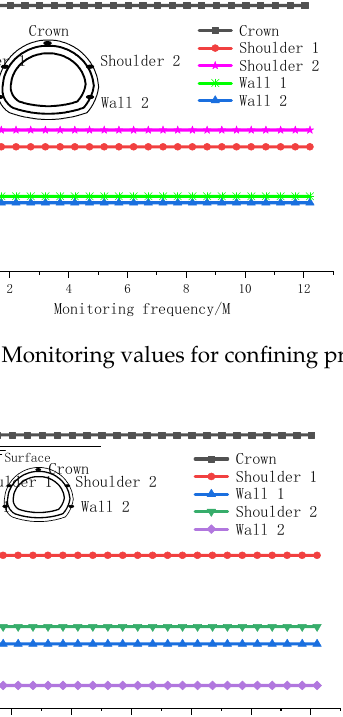
Figure 13. Crack warning method for CFRP reinforced tunnel lining.